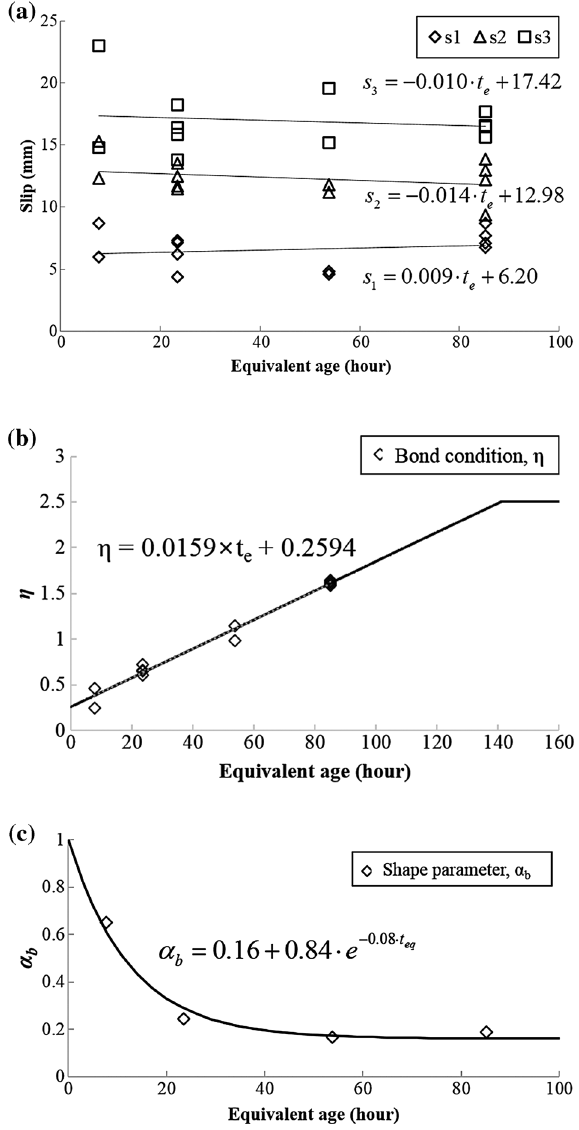
Fig. 8 Model parameters as functions of t e . a Slip values at characteristic points, b value of g as a function of t e and c value of a b as a function of t e